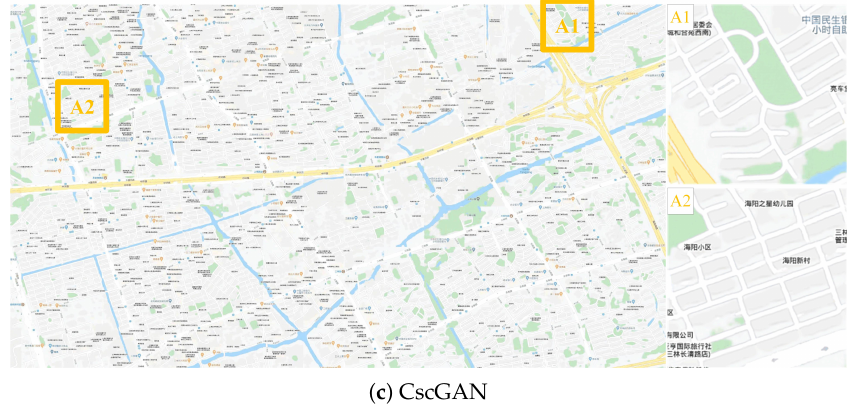
Figure 17. The generation results with level 18 via the proposed CscGAN in Minhang District of Shanghai. For clarity, the zoomed local areas (A1 and A2) are on the right of the